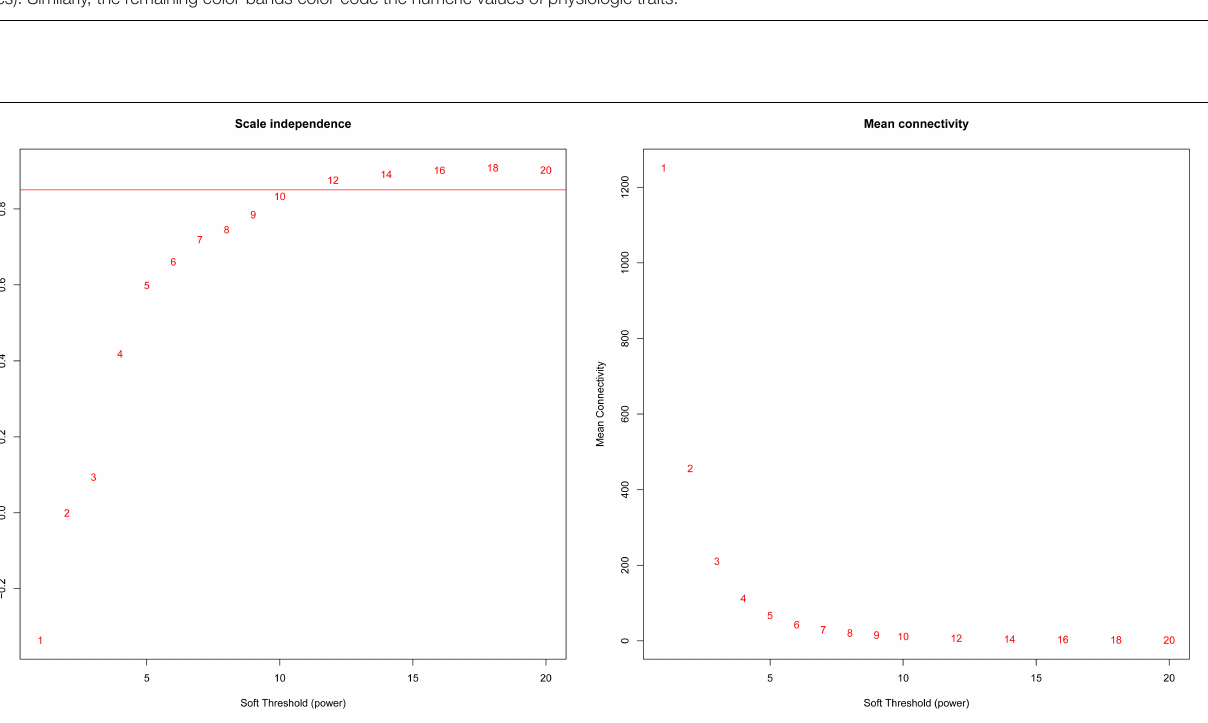
FIGURE 1 | Sample dendrogram and trait heatmap. The leaves of the tree correspond to osteoarthritis (OA) samples and non-steoarthritis (non-OA) samples. The first color band underneath the tree indicates which arrays appear to be outlying. The second color band represents disease stages which indicate OA and non-OA (red indicates high values). The third color band represents tissue sources which indicate samples from knee lateral tibial (LT) and medial tibial (MT) (red indicates high values). Similarly, the remaining color-bands color-code the numeric values of physiologic traits.